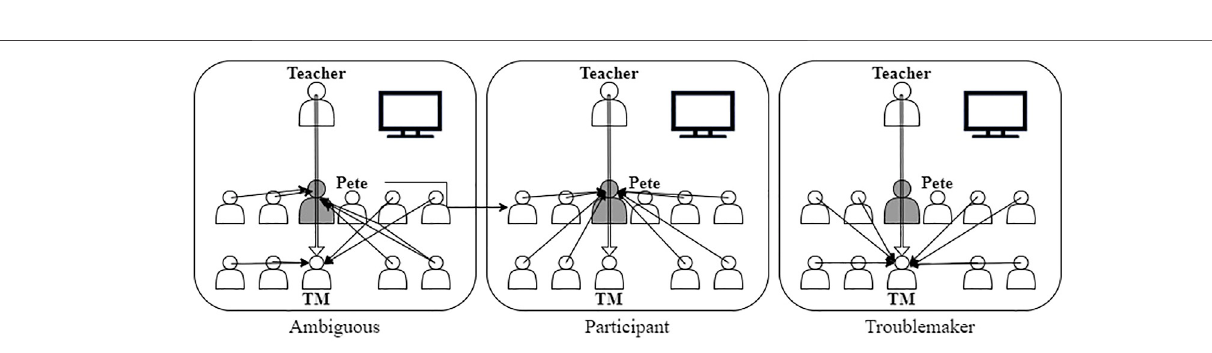
FIGURE 5 | Classroom setup in the Classroom scenario, going through three possible intensity conditions of stress induction concerning the direction of the student ’ s gazes towards the (dark grey) participant in the center: Ambiguous, Participant, Troublemaker (TM).